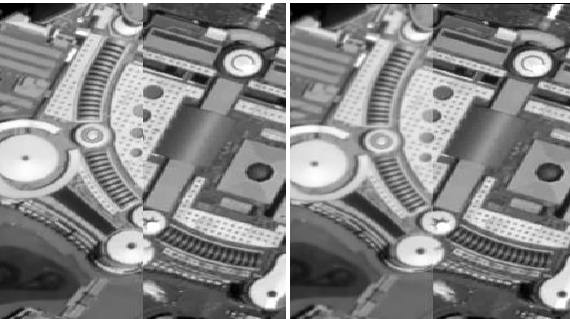
Figure 1: The developed methodology manages to co-register the acquired video frames. Unregistered frames (left), registered fra- mes after the application of the developed method (right). Data are from Skybox Imaging (Terra